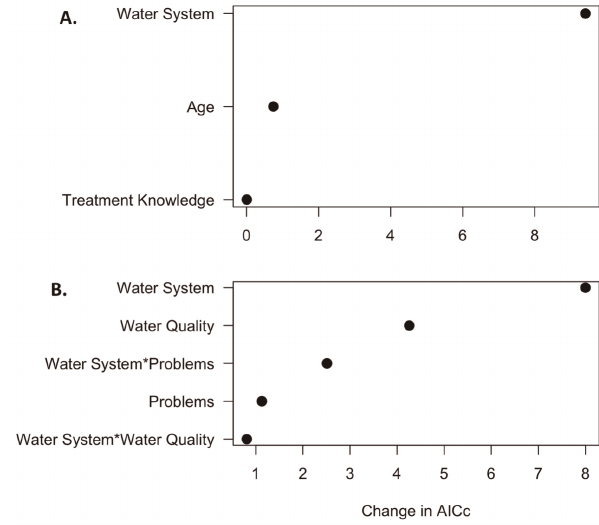
Figure 3. Importance of Each Covariate for Model Fit in the Two Models that Predict Household Water Management Strategies. Change in AIC c for each of the covariates considered in the full logit model for the number of drinking water sources (A) and whether households treat or do not treat water (B). Larger changes in